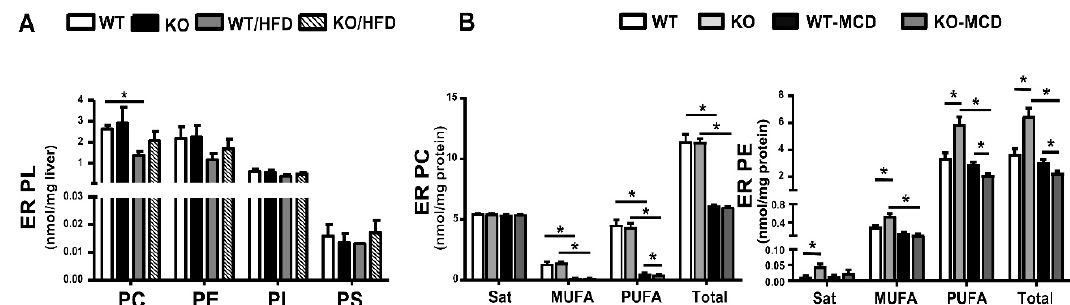
Figure 6. iPLA 2 β inactivation on PL profiles of liver ER fractions of HFD- and MCD-fed mice. Feeding with HFD or MCD diet was described in Figures 4 and 5, respectively. ER fractions were isolated from mouse livers and ER proteins subjected to PL profiling by LC-MS / MS. ( A ) The contents of PC, PE, PI, and PS in the ER of WT, iPLA 2 β -KO, WT / HFD, and iPLA 2 β -KO / HFD livers. ( B ) Saturated, MUFA, PUFA, and total contents of PC and PE in liver ER fractions of WT, iPLA 2 β -KO, WT / MCD, and iPLA 2 β -KO / MCD livers. Data are mean ± SEM, N = 5–12 for (A) and 5–6 for (B); *, p < 0.05, between indicated pairs.